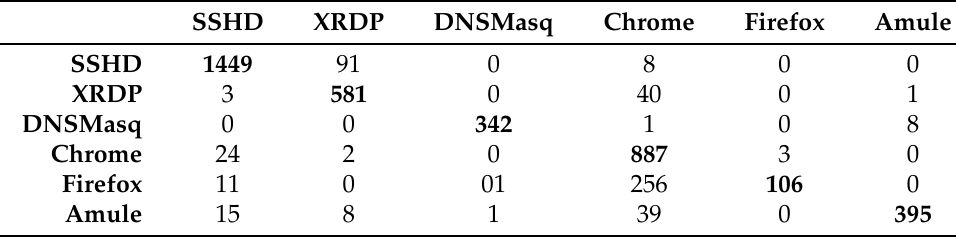
Table 18. Proposed method: confusion matrix (UPC,